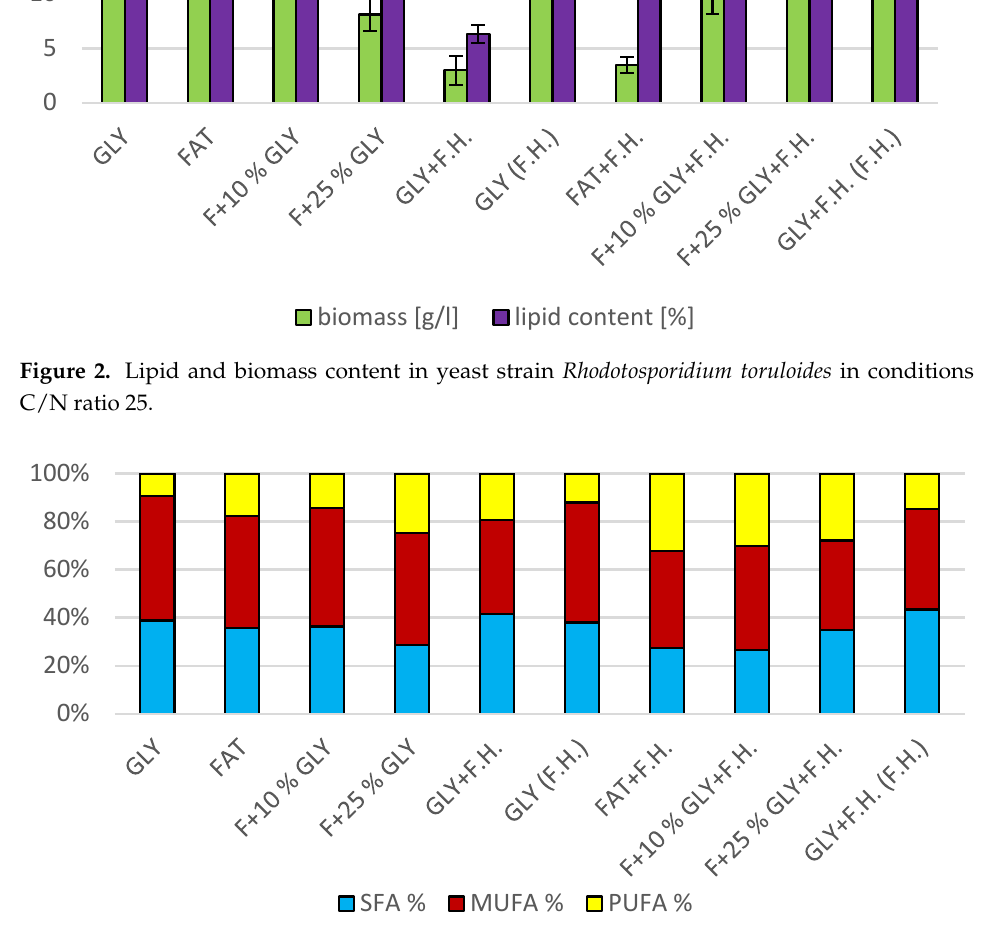
Figure 3. Fatty acid distribution in lipids of yeast strain Rhodotosporidium toruloides in conditions of C/N ratio 25.